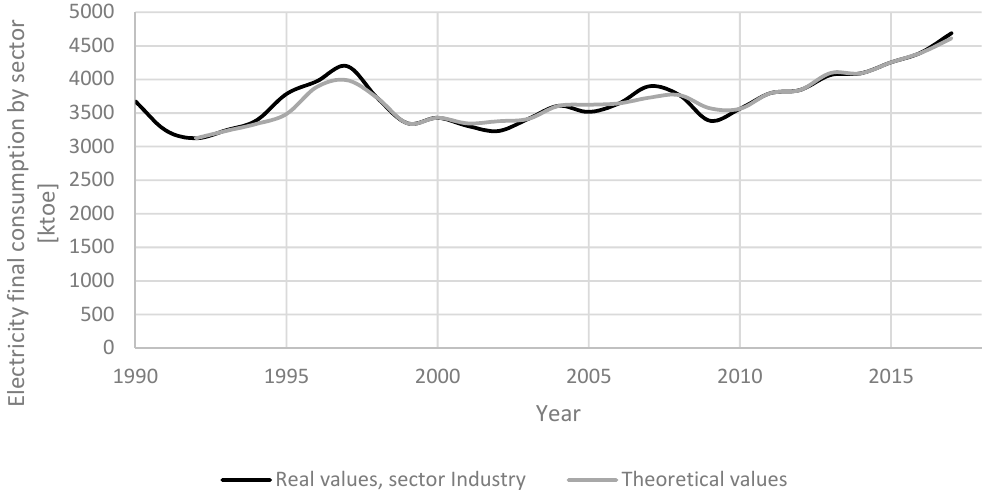
Figure 8. The comparison of the theoretical and actual values of final electricity consumption for industry sector, ktoe, source: own study.